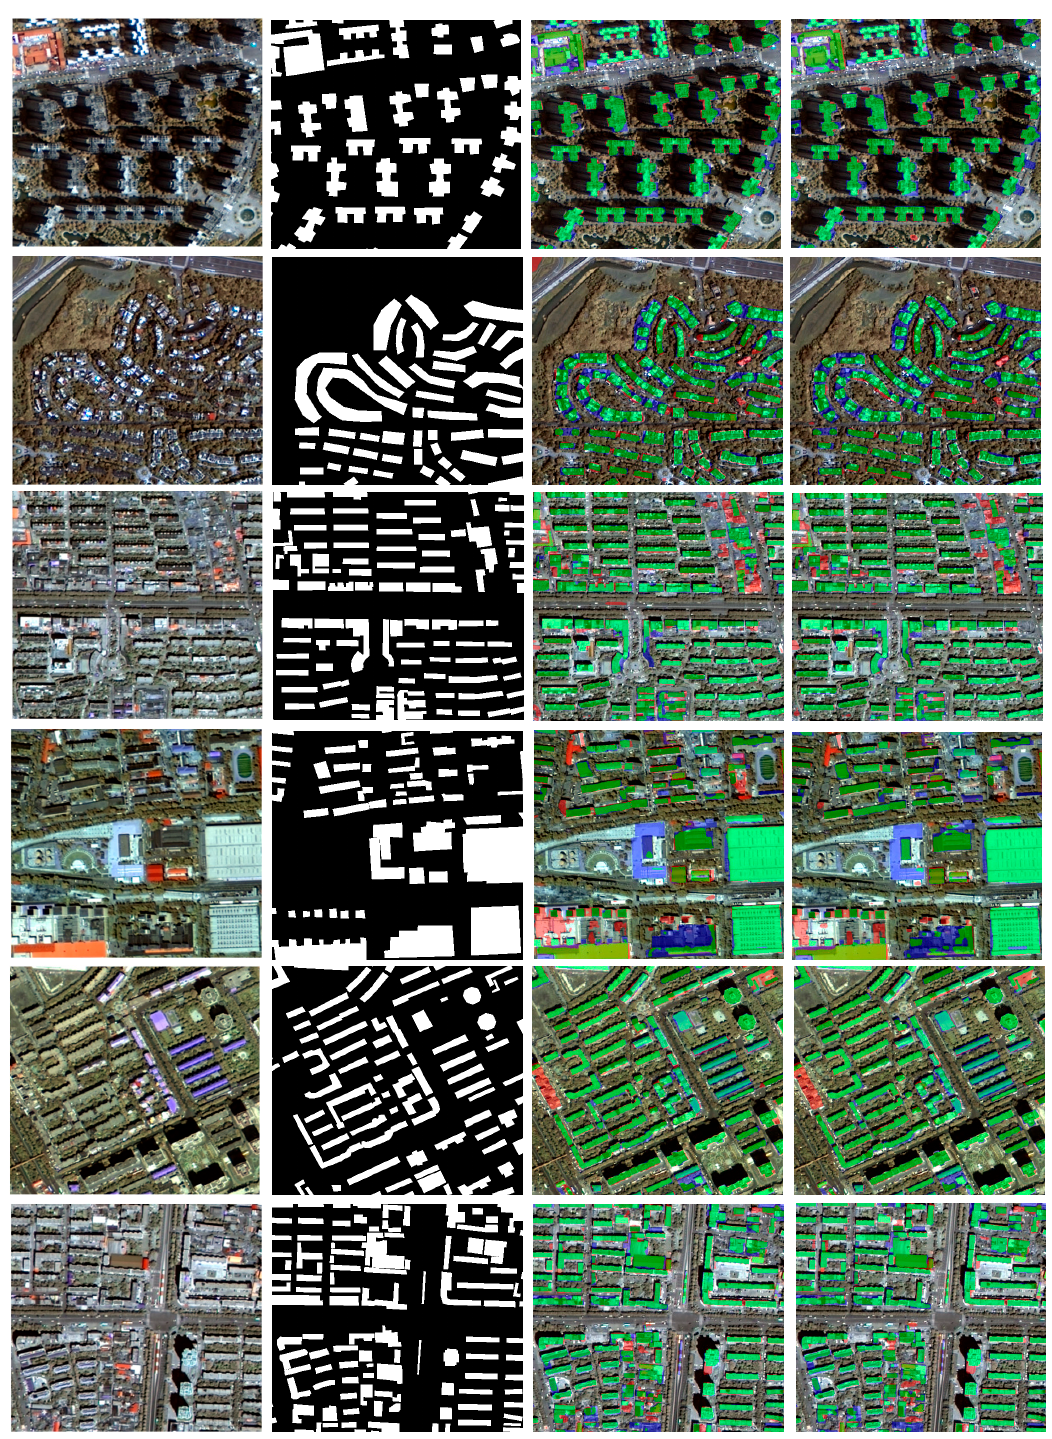
Figure 4. Visual comparison of the building roof segmentation results in different urban environment: for each row, images from left to right are true color composite GF2 PMS imagery (512 Pixel × 512 Pixel), manual delineation of building roof, DCNN segmentation results and CRF-refined building roof segmentation, respectively; for the images with segmentation results, green mask is True Positive (TP, building roof pixel was correctly classified), blue mask is False Negative (FN, building roof pixel was classified as non-building roof) and red mask is False Positive (FP, non-building roof pixel was classified as building roof).